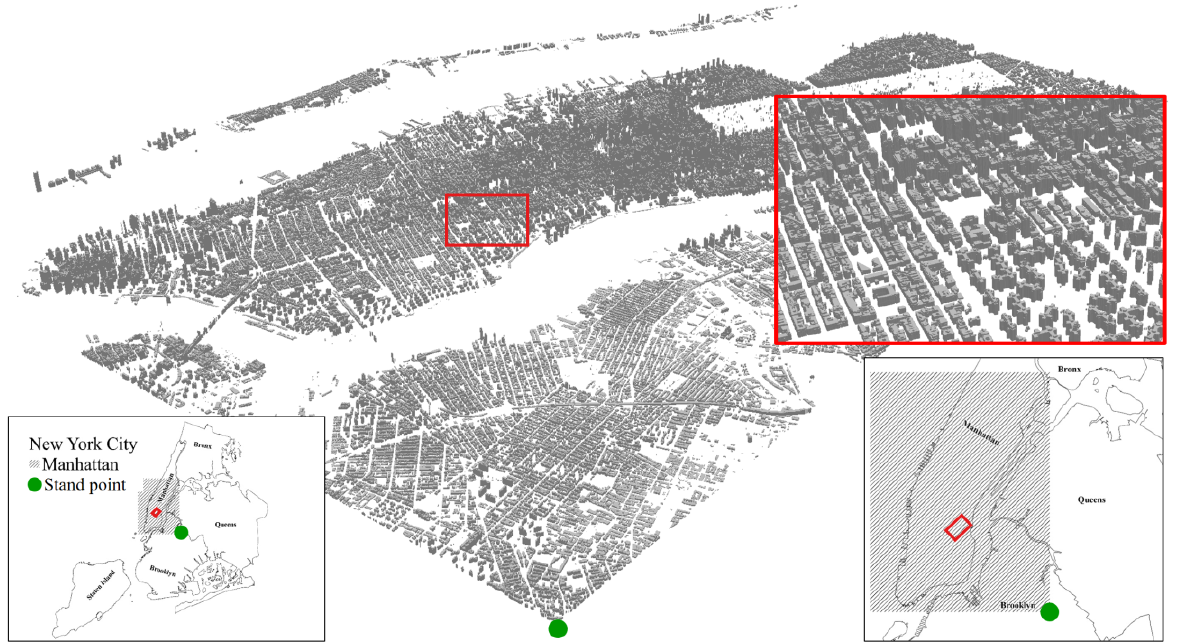
Figure 1. Results from our proposed 3D city reconstruction pipeline depicting the 3D city block models of the Manhattan area. The semantic segmentation was conducted with model denoted as b1_2_128 in Table